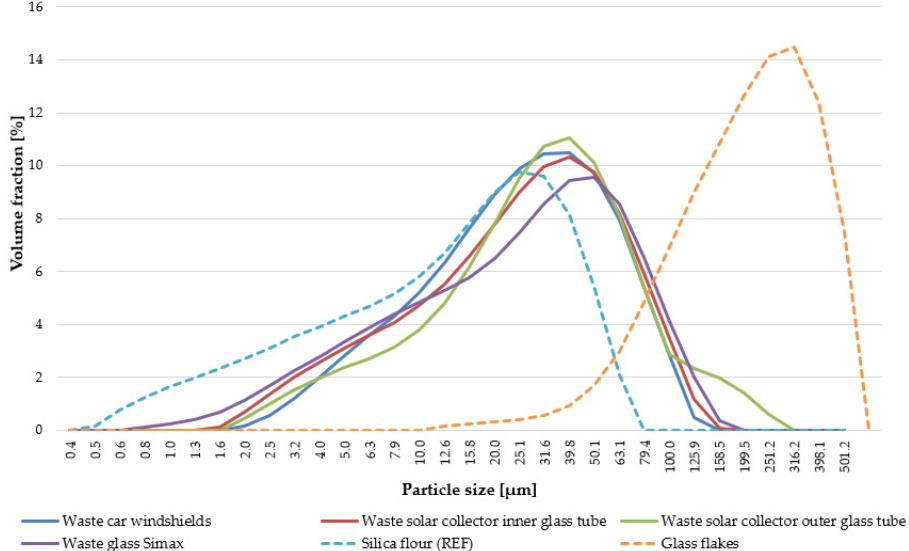
Figure 1. Particle size distribution for both the reference and waste fillers.